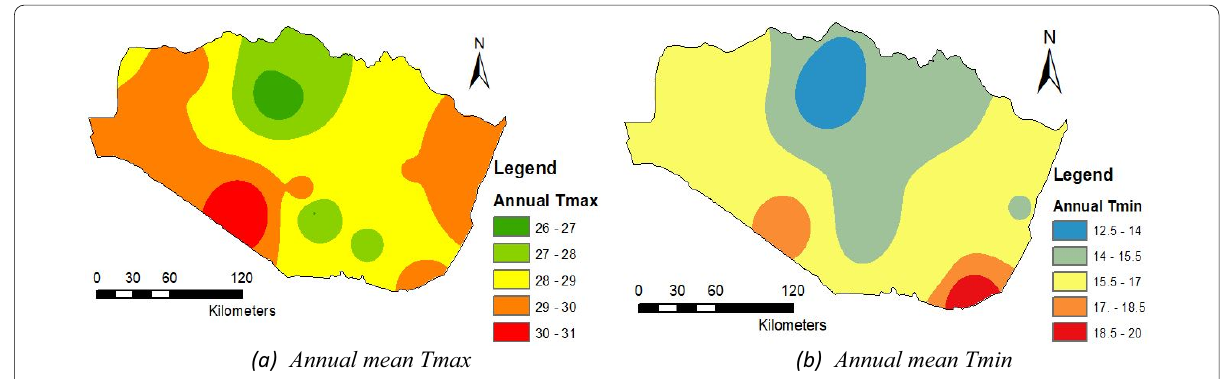
Fig. 11 Spatial distribution of annual mean Tmax (a) and Tmin (1981–2018)